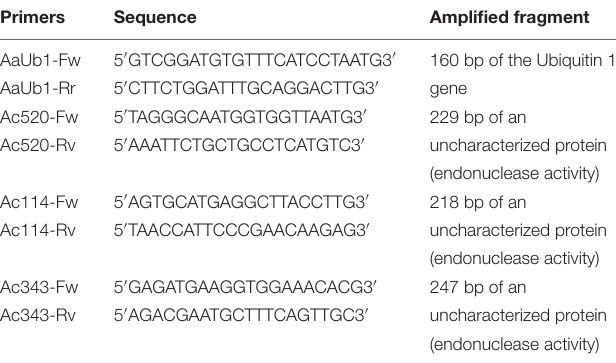
TABLE 1 | Primer sequences used in this